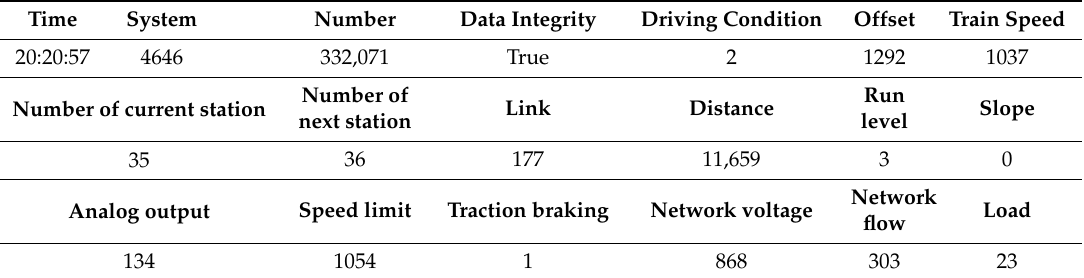
Table 2. Train operation information saved by Vehicle On Board Controller.